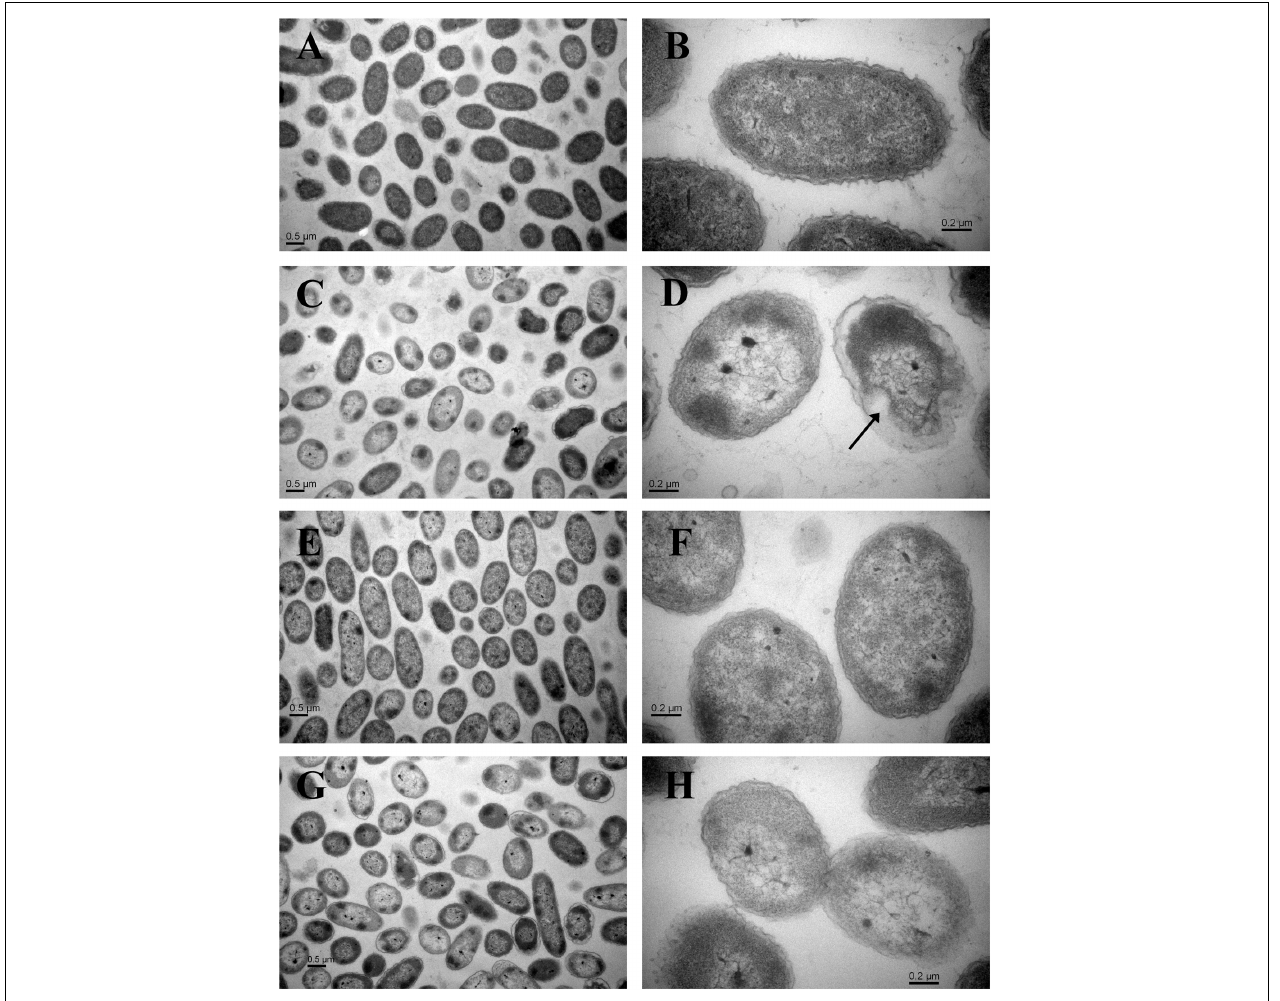
FIGURE 3 | Transmission electron microscopy (TEM) examination of cells. (A) Wide view of the C4 strain without HPP treatment. (B) Magnified view of the C4 strain without HPP treatment. (C) Wide view of the C4 strain following 200 MPa HPP treatment for 10 min. (D) Magnified view of the C4 strain following 200 MPa HPP treatment for 10 min. (E) Wide view of the N11 strain without HPP treatment. (F) Magnified view of the N11 strain without HPP treatment. (G) Wide view of the N11 strain following 200 MPa HPP treatment for 10 min. (H) Magnified view of the N11 strain following 200 MPa HPP treatment for 10